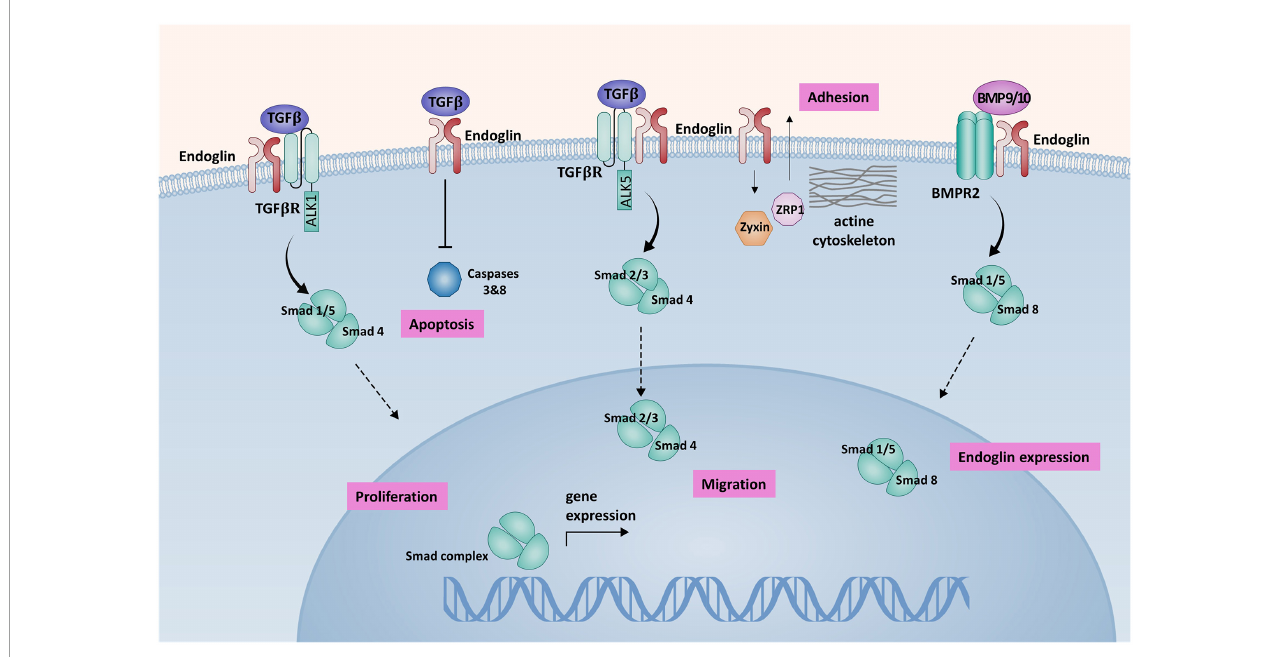
FIGURE1 A schematic presentation of endoglin-mediated signaling in endothelial cells (ECs). Endoglin associates with TGF- β RII and ALK1 forming a receptor complex, that binds TGF- β 1. Activation of this receptor complex leads to the phosphorylation of Smad1/5 that form a complex with co-Smad (Smad4). Smad complex is then translocated to the nucleus, where it regulates the expression of target genes, promoting cell proliferation. Association of endoglin with the ALK5/TGF- β II receptor complex inhibits Smad2/3 dependent signaling pathway, that has an antiproliferative effect on ECs. Endoglin promotes BMP9/10 signaling via BMPR2 receptor complex. Activation of BMPR2 receptor complex leads to Smad1/5/8 phosphorylation and subsequent increased endoglin expression in a positive feedback loop. Binding of TGF- β by endoglin induces inhibition of apoptosis via caspases 3 and 8 inhibition. Endoglin interaction with ZRP-1 and Zyxin regulates cell migration, inducing the reorganization of actin cytoskeleton and promoting cell adhesion